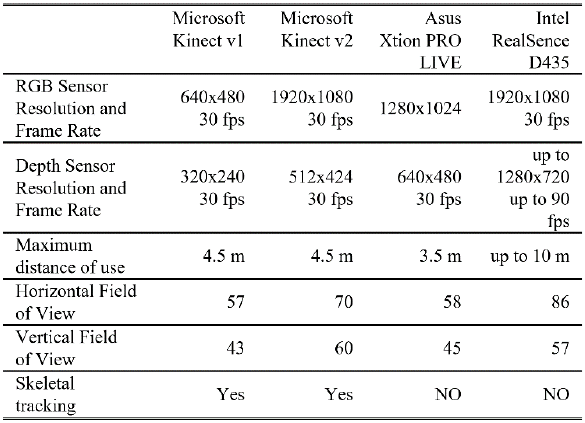
Table 1. Main features of RGB-D cameras Figure 3. Representation of fall action segments (red),